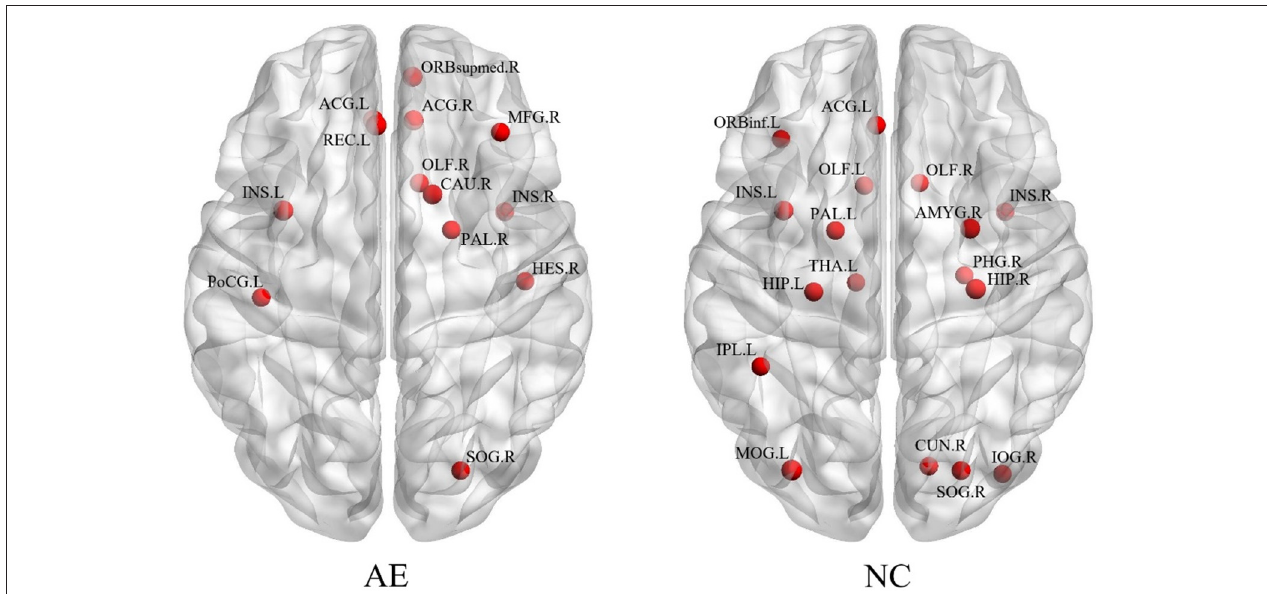
FIGURE 2 | The brain regions with different network parameters in the encephalitis patient group and healthy control group were